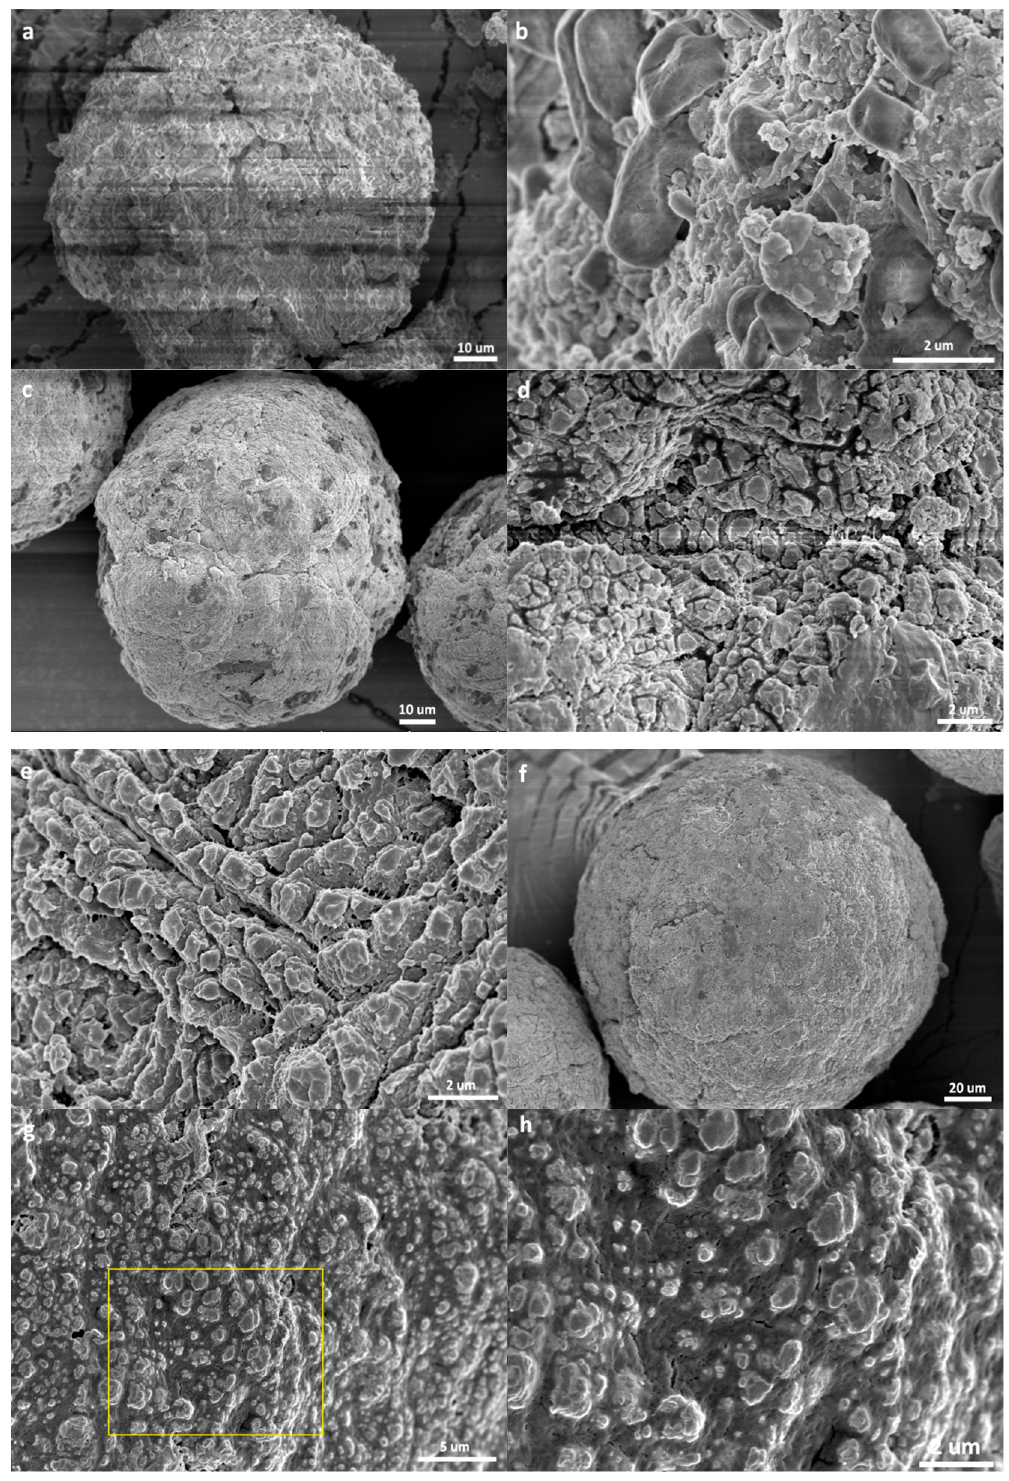
Figure 4. SEM pictures of PP/catalyst particles formed at different polymerization times: ( a,b ) 30 s; ( c,d ) 60 s; ( e ) 120 s; ( f,g,h ) 180 s (samples P1, P2, P3, and P4 in Table 1).